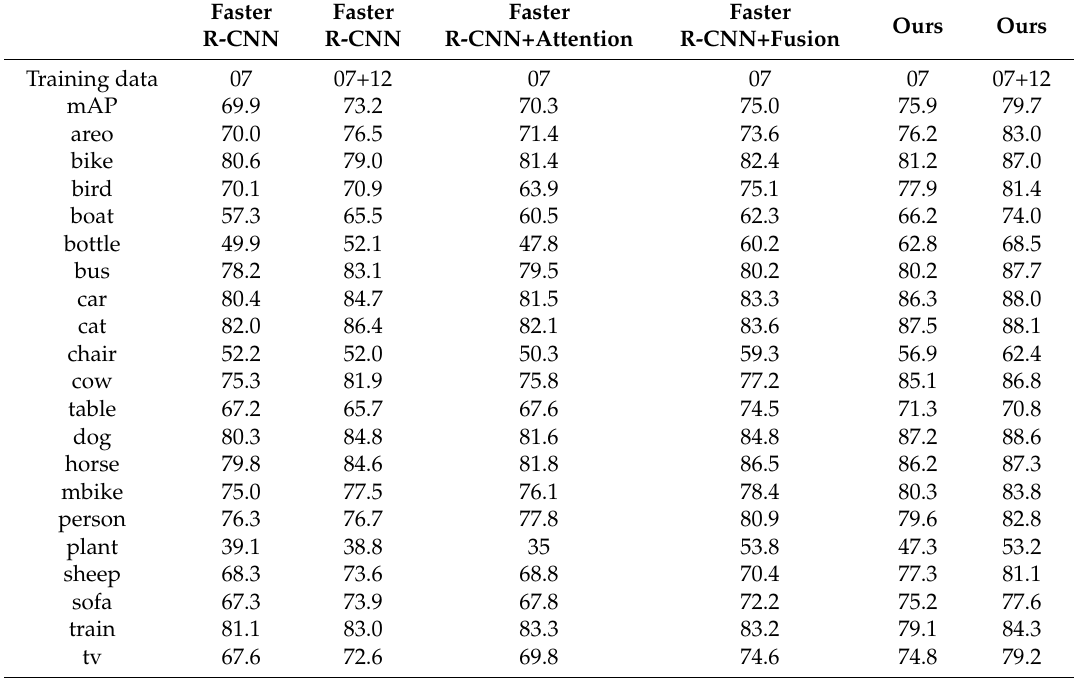
Table 1. Results of the Faster R-CNN and AF R-CNN on the dataset, PASCAL VOC 2007. Faster Faster Faster Faster R-CNN R-CNN R-CNN+Attention R-CNN+Fusion